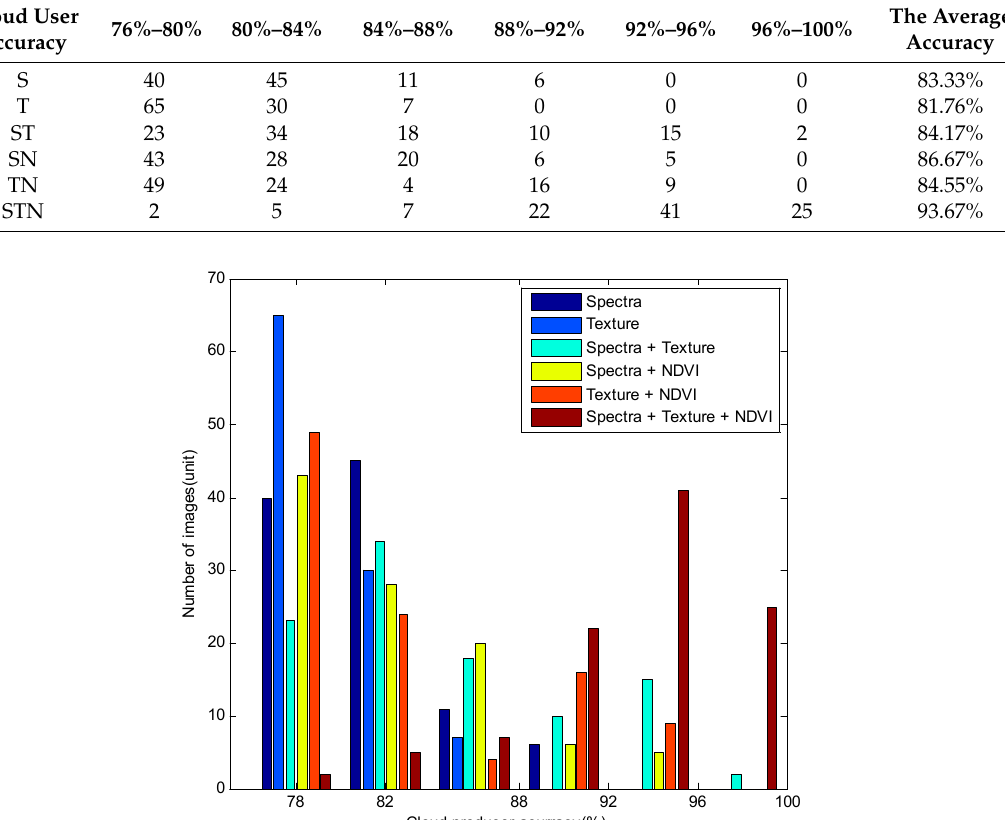
Table 5. Cloud producer accuracy for Spectra (S), Texture (T), Spectra + Texture (ST), Spectra + NDVI